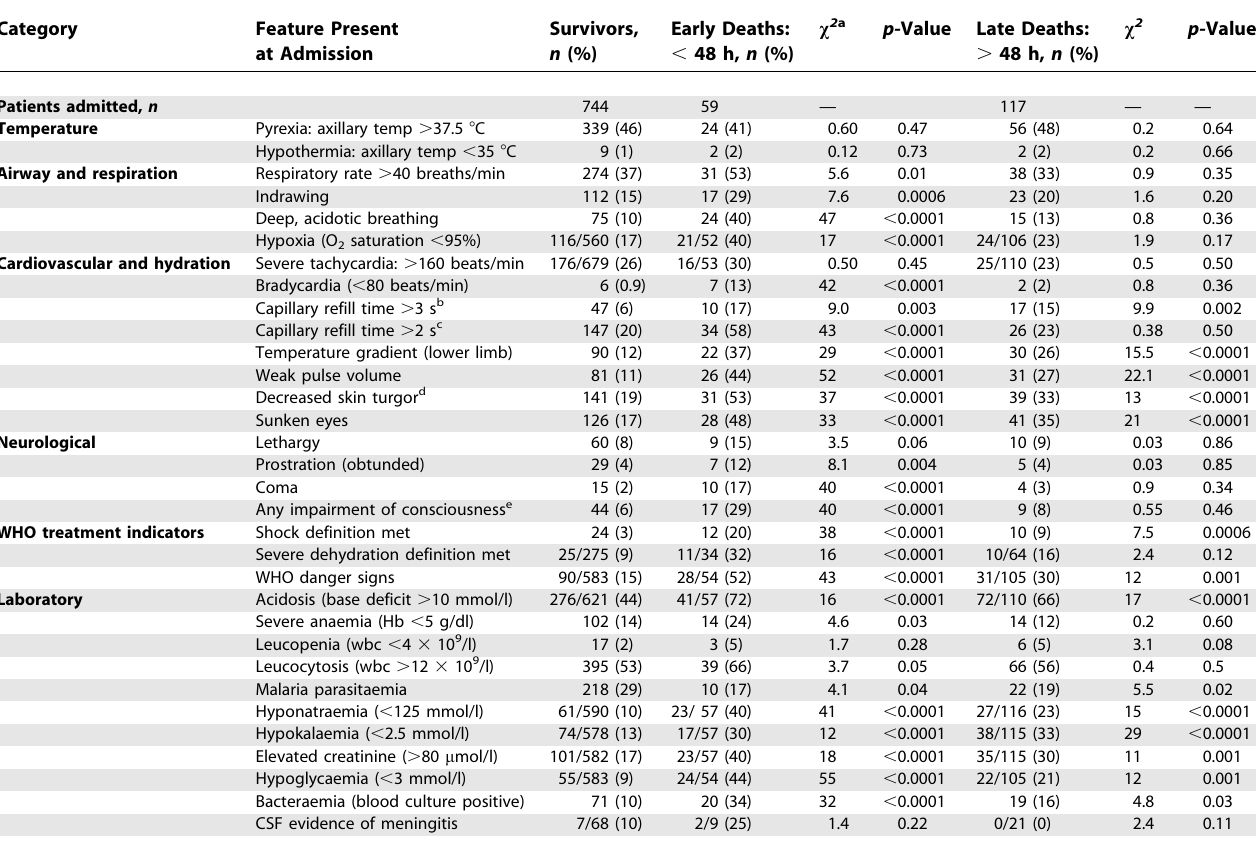
Table 1. Clinical Features in Survivors and Early and Late Fatalities Category Feature Present at